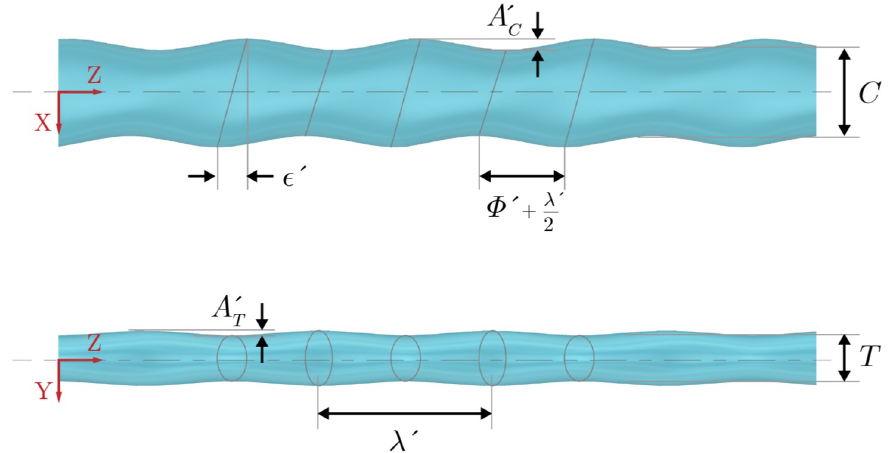
Fig 3. Schematic of baseline whisker model. Schematic shows the hydrodynamic-based geometric parameters that define the undulation features as described in Table 1. Top view (top panel) and front view (bottom panel), where flow is along the positive x -axis.